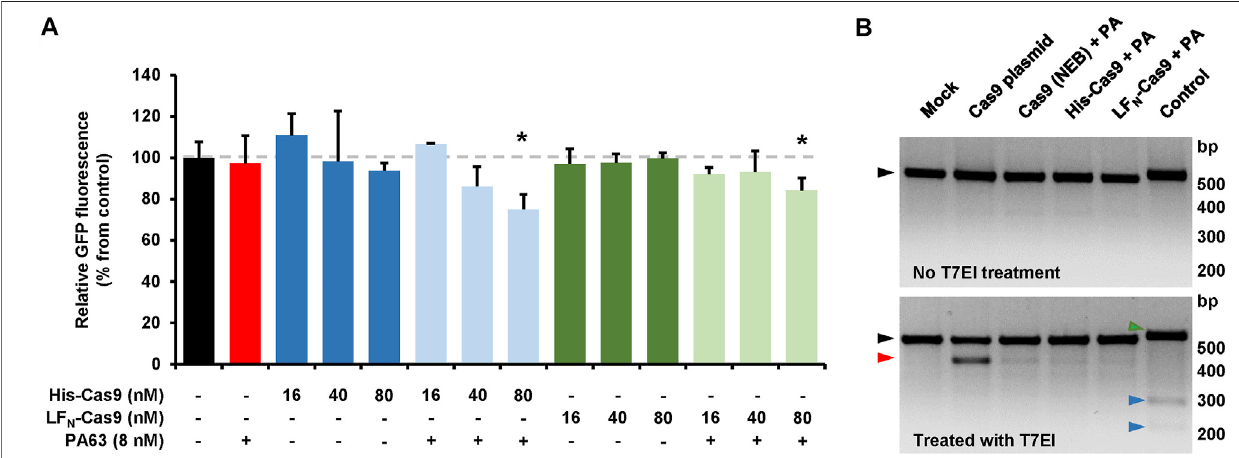
FIGURE5| CRISPA-mediatedknockoutofGFPin293TGFPcells. (A) 293TGFPcellstransfectedwithagRNA-expressingplasmidtargetingGFPwereincubated the following day either with indicated concentrations of His- or LF N -Cas9 alone (dark colored blue and green bars) or together with 8 nM PA63 (light colored blue and greenbars).Red barindicatescellstreatedwith8 nMPA63only.Blackbarrepresentsmock-treatedcells(control). Bardiagram showsthemedian GFP fl uorescenceof cells after 6 days of incubation relative to control, which was set to 100%. Results shown are mean values calculated from three samples performed in parallel and with error bars indicating n (cid:2) 3 ± SD (* p < 0.05) (B) T7 endonuclease I mismatch detection assay. 293T-GFP cells transfected with a plasmid encoding a GFP-speci fi c gRNA were incubated for 24 h with 10 nM PA63 (PA) together with 100 nM His- and LF N -Cas9, respectively, or a commercial Cas9 protein carrying an N-terminal His- tag (denoted as Cas9 (NEB)). Cells co-transfected with a Cas9-expressing plasmid (Cas9 plasmid) served as positive control and cells without Cas9 as negative control (mock). A T7 endonuclease I (T7EI) mismatch detection assay was performed with all cell populations and subsequently analyzed by agarose gel electrophoresis. Black trianglesindicatePCR-derivedDNAtemplatesfromallCas9-treatedcellpopulationswith(lowerpanel)orwithout(upperpanel)T7EItreatment.Theredtriangleindicates the T7EI-derived cleavage product in the Cas9-treated cell populations. Green and blue triangles indicate DNA template (516 bp) and cleavage products (225 and 291 bp) of the internal kit control (control), respectively. bp, base pairs (A, B) Experiments were performed at least twice with identical results.